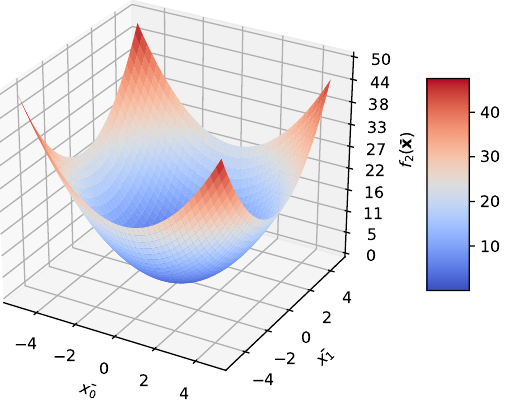
Figure 15. Chart showing values of f 2 ( ¯x ) , with x 0 and x 1 from − 5 to 5.